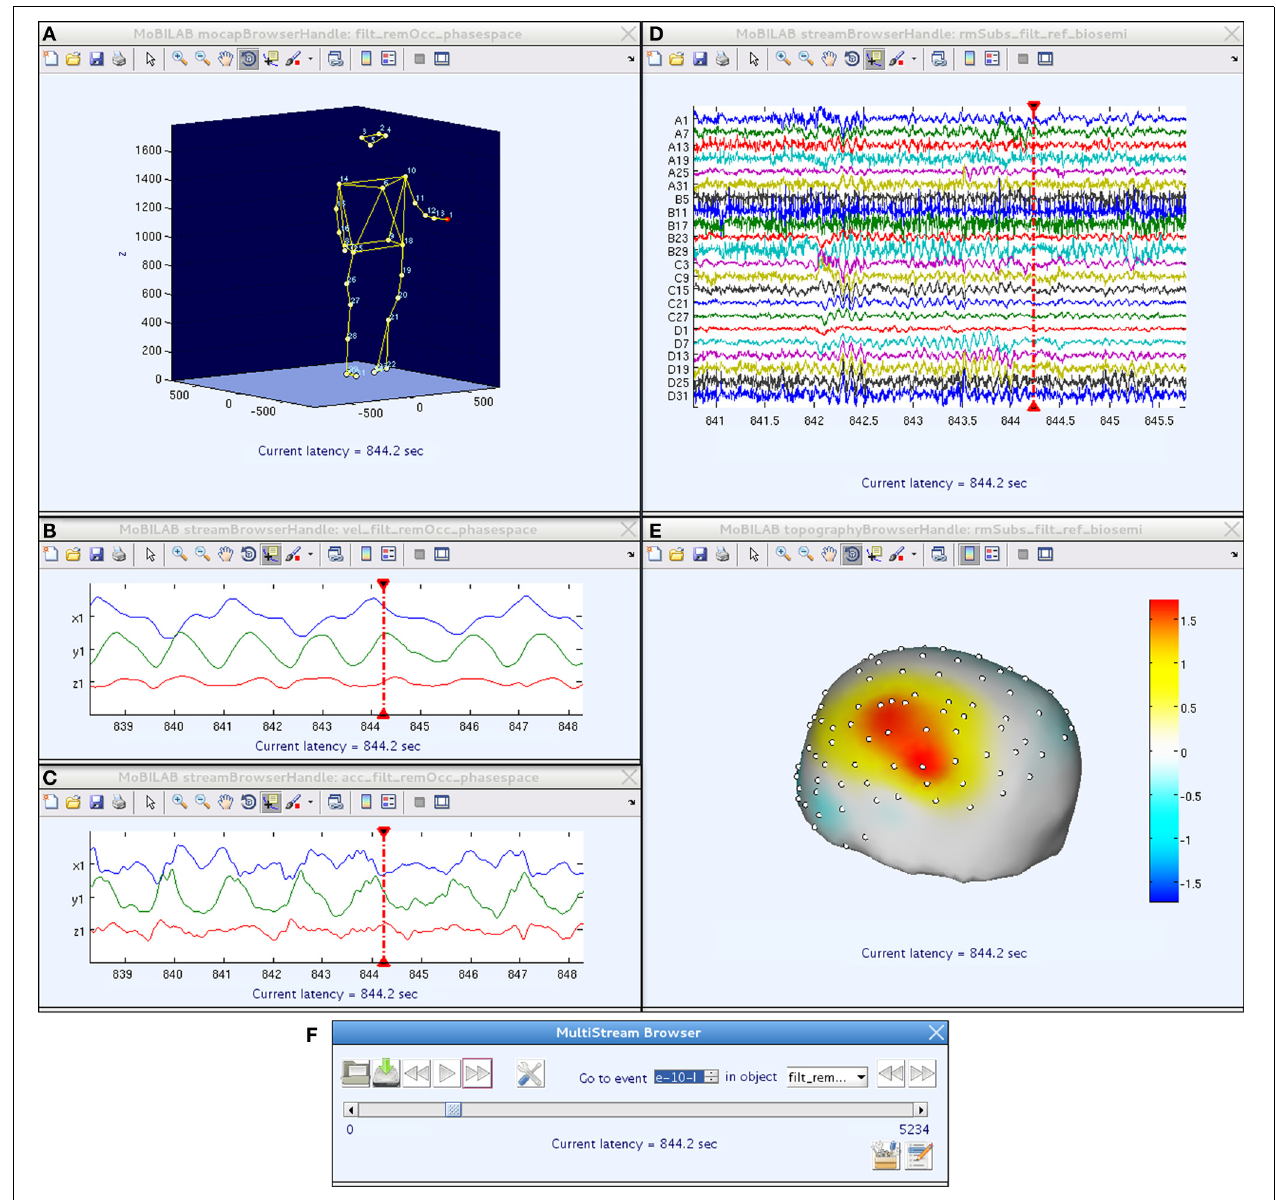
FIGURE 3 | A MoBILAB Multi-Stream Browser session comprising five (top) MATLAB figure windows that give user-selected, temporally coordinated views of raw and/or derived data streams within a multi-stream MoBI dataset, plus (bottom) a browser control window. (A) Full body motion capture of participant’s rhythmic hand and arm movements, animated on a 3-D human stick figure whose body position depicts subject position at the current moment (CM) in the data, marked in the scrolling time series data windows by CM indicators (vertical red lines). (B,C) Derived (x, y, z) velocity and acceleration time series for the (red) left